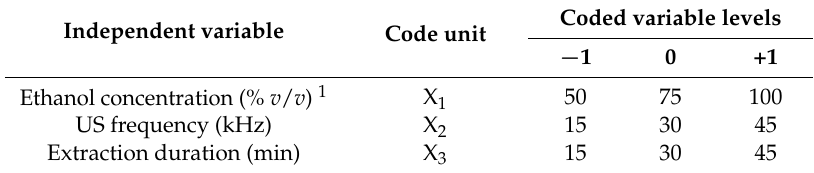
Table 1. Identities, code unit, coded levels and actual experimental values of the three independent